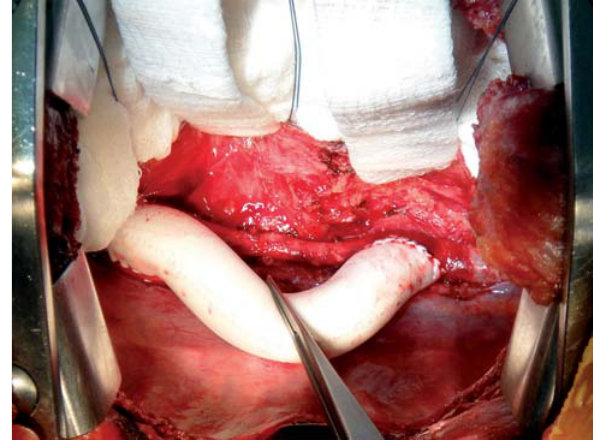
Fig. 4 / Vídeo2 (http://www.rbccv.org.br/video/v25n4c/) – Tubo de politetrafluoretileno nº16 implantado, sem auxílio de